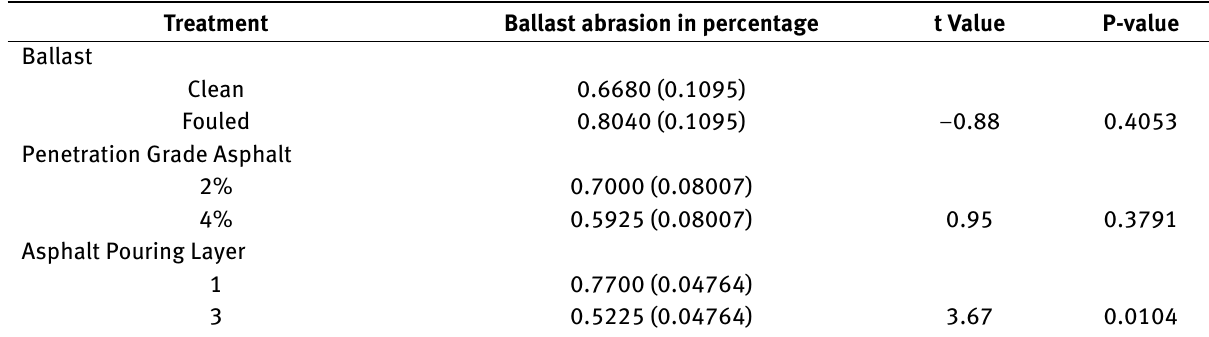
on the ballast surface (FB1-4%). In specimen FB1-4%,